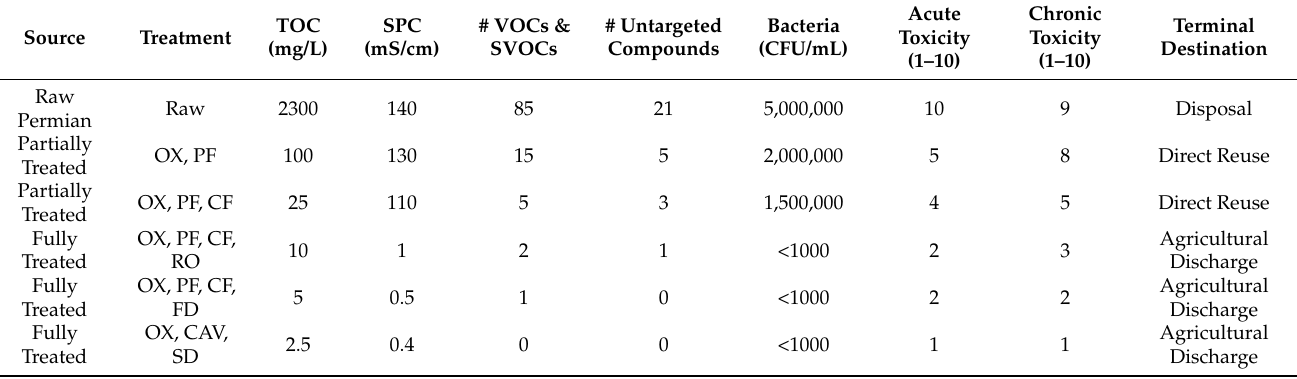
Table 1. Hypothetical examples of the possible relationships between TOC, conductivity, acute and chronic toxicities, and the presence of various organic and biological constituents found in FPs of varying water quality. OX: oxidizing agent, PF: particulate filtration, C: carbon filtration, RO: